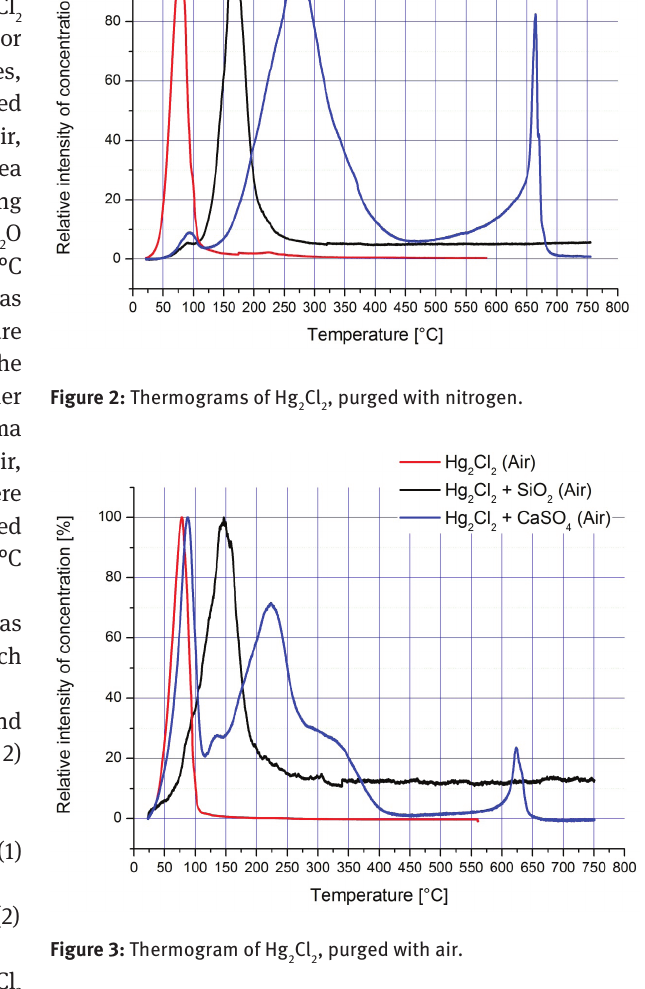
Figure 3: Thermogram of Hg